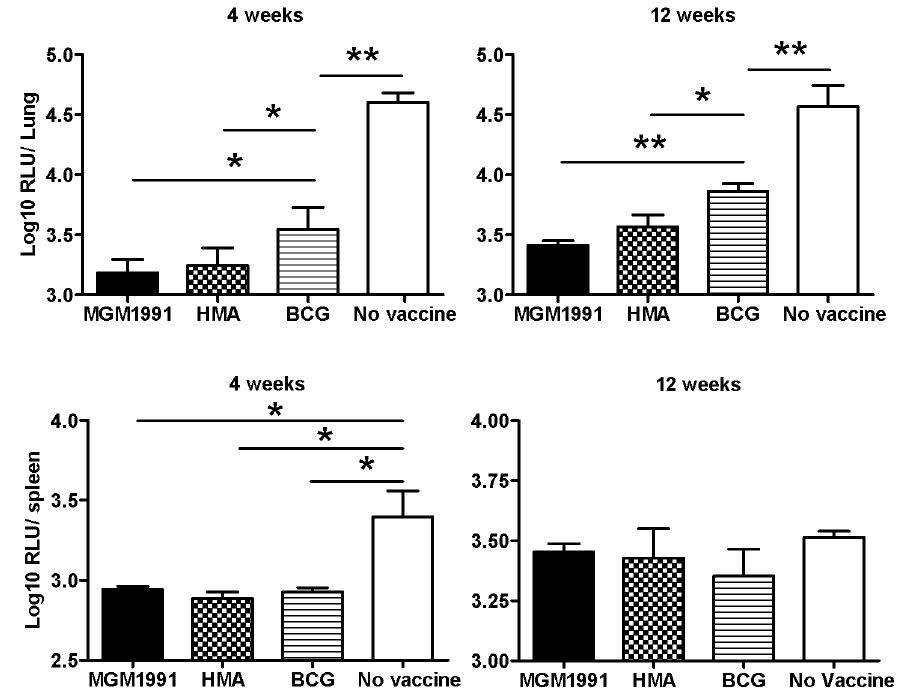
Figure 6. Bacterial replication in lungs and spleen of C57BL/6 mice vaccinate d with MGM1991, HMA or BCG and challenged with 10 4 CFU of virulent luminescent M. tuberculosis . Mean number of bacteria in lungs and spleen of mice vaccinated with 5x10 4 MGM1991, HMA or BCG or unvaccinated mice (naïve), challenged 12 weeks later with 10 4 CFU of virulent M.tb by the intratracheal route and sacrificed 4 and 12 weeks after challenge. Results are reported as mean log (RLU) ± SD of 5 mice tested individually; * p < 0.05; ** p < 0.01 (Mann-Whitney test) .